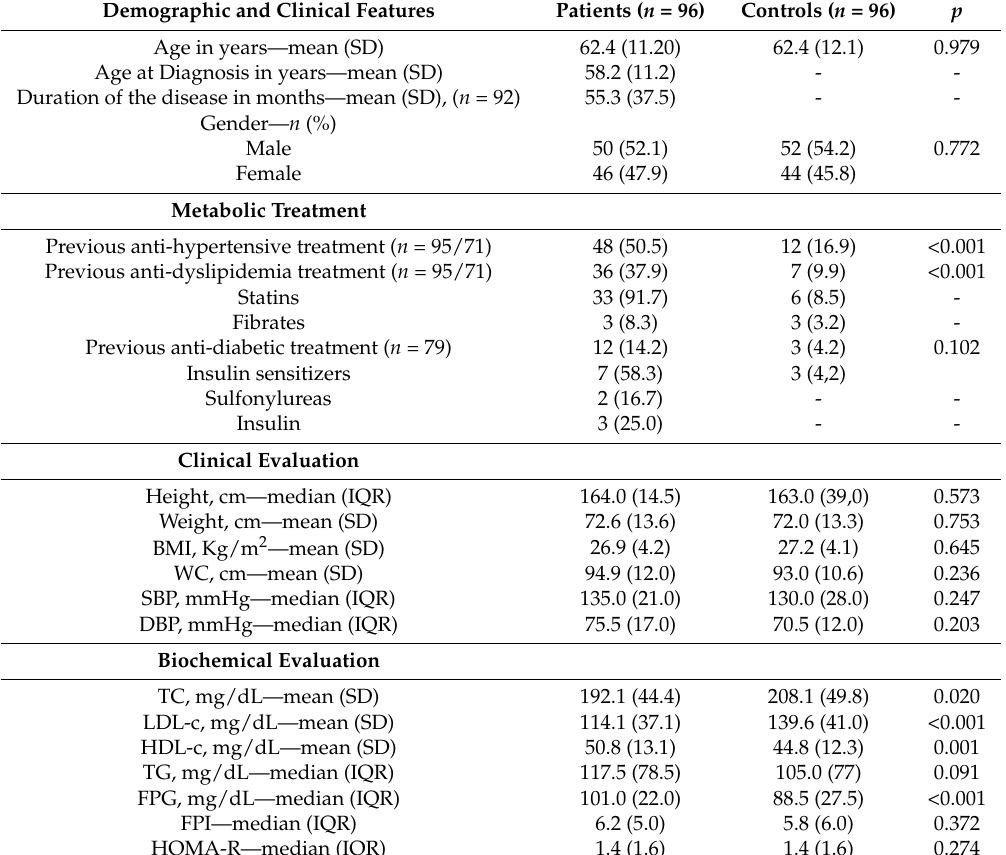
Table 1. Demographic, anthropometric, clinical, and biochemical features of patients with WD GEP-NETs and controls.